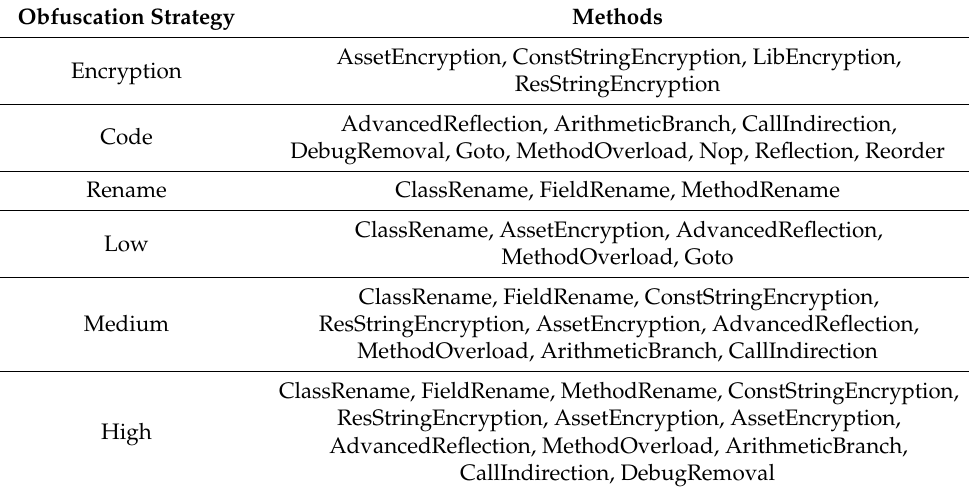
Table 5. Obfuscation